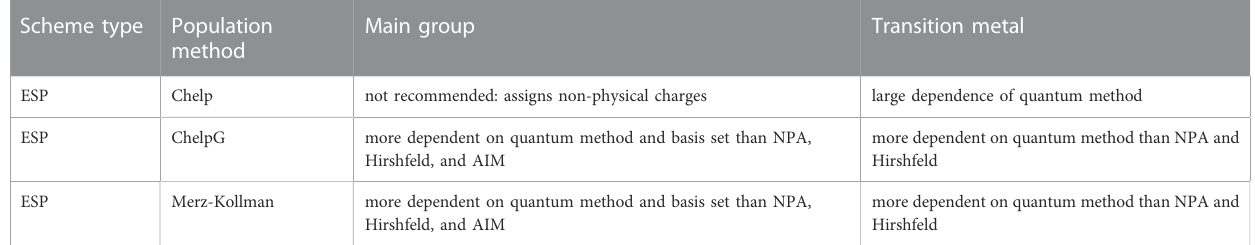
TABLE 4 Basis set and quantum method dependencies from electrostatic potential population analysis methods applied to main group and transition metal molecules. Scheme